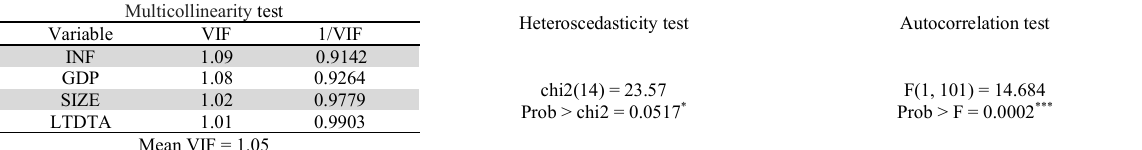
Results of VIF, heteroscedasticity and autocorrelation tests (Model